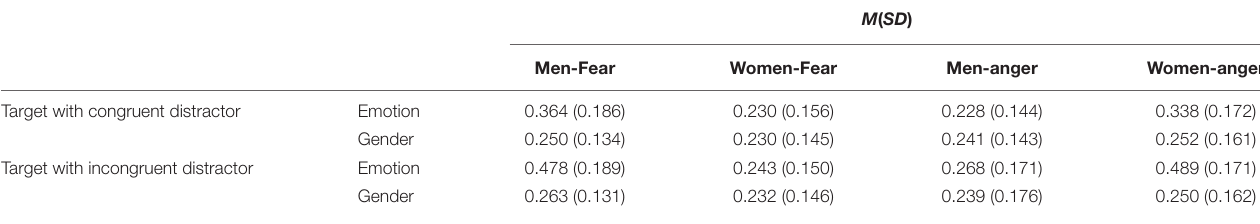
TABLE 1 | Mean error rates and standard deviations for all